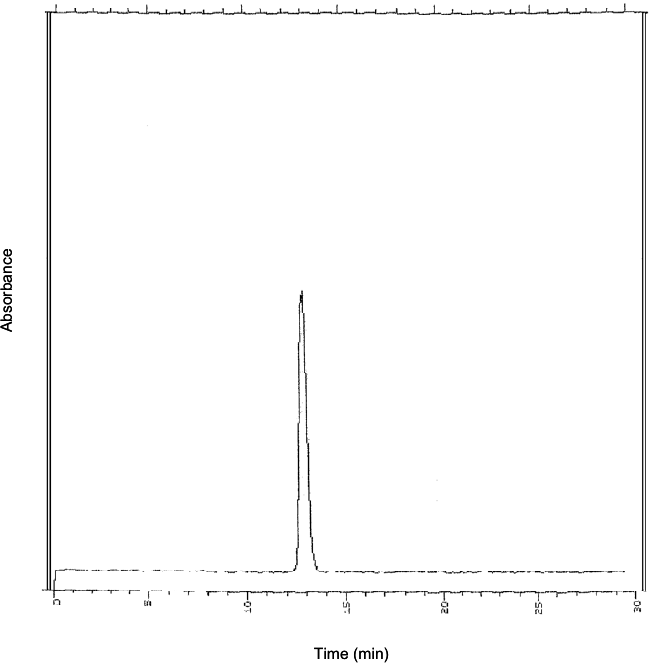
FIGURE 4 – Radio-HPLC elution profile of 99m Tc-HYNIC-RGDyK.